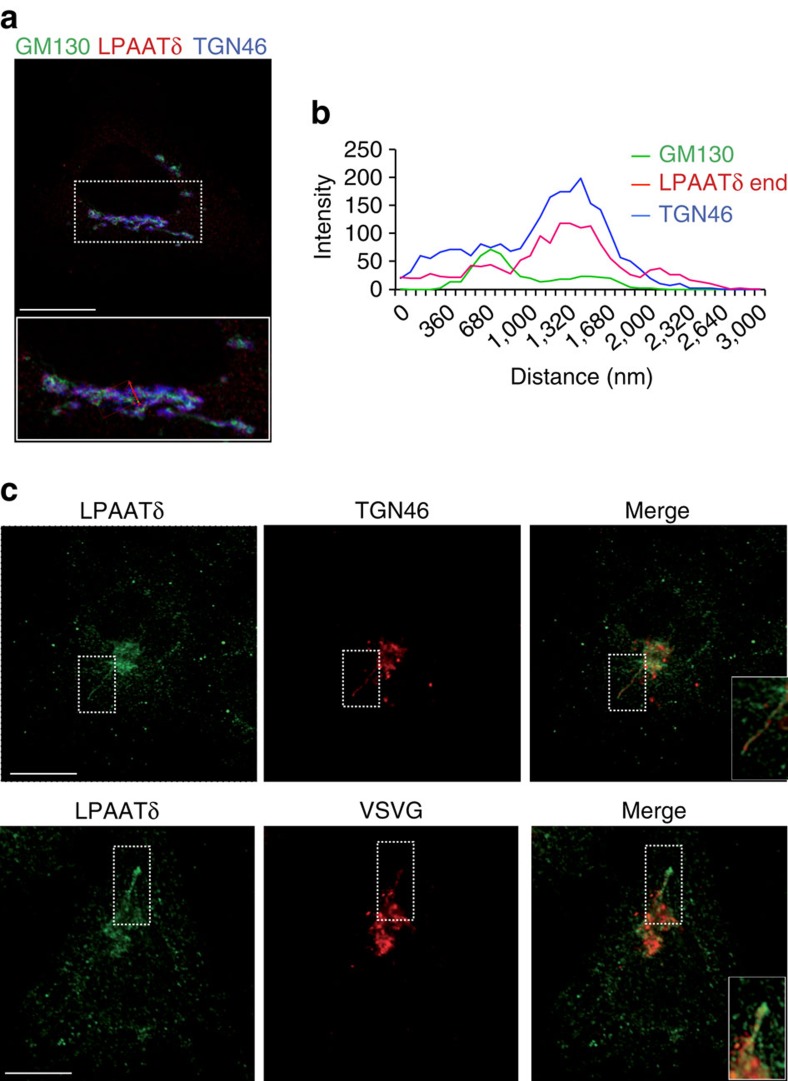
LPAATδ is a trans-Golgi–localized enzyme.(a) Representative confocal microscopy image of HeLa cells at steady-state fixed and labelled with a polyclonal anti-LPAATδ antibody (endogenous LPAATδ; red), with a monoclonal anti-GM130 antibody (green) and with an anti-TGN46 antibody (blue). Inset, bottom: Magnification of Golgi area. (b) Line scan across the Golgi area (red line across the magnified image in a) indicates the colocalization of LPAATδ with TGN46. (c) Representative confocal microscopy images of COS7 cells at steady-state (top) or VSV-infected and subjected to the VSVG TGN-exit assay (bottom). Cells were fixed and labelled with a polyclonal anti-LPAATδ antibody (endogenous LPAATδ; green) and with an anti-TGN46 antibody (red; top) or a monoclonal anti-VSVG antibody (red; bottom). Inset, right: magnification of tubular carrier precursors. Scale bars, 10 μm (a,c).